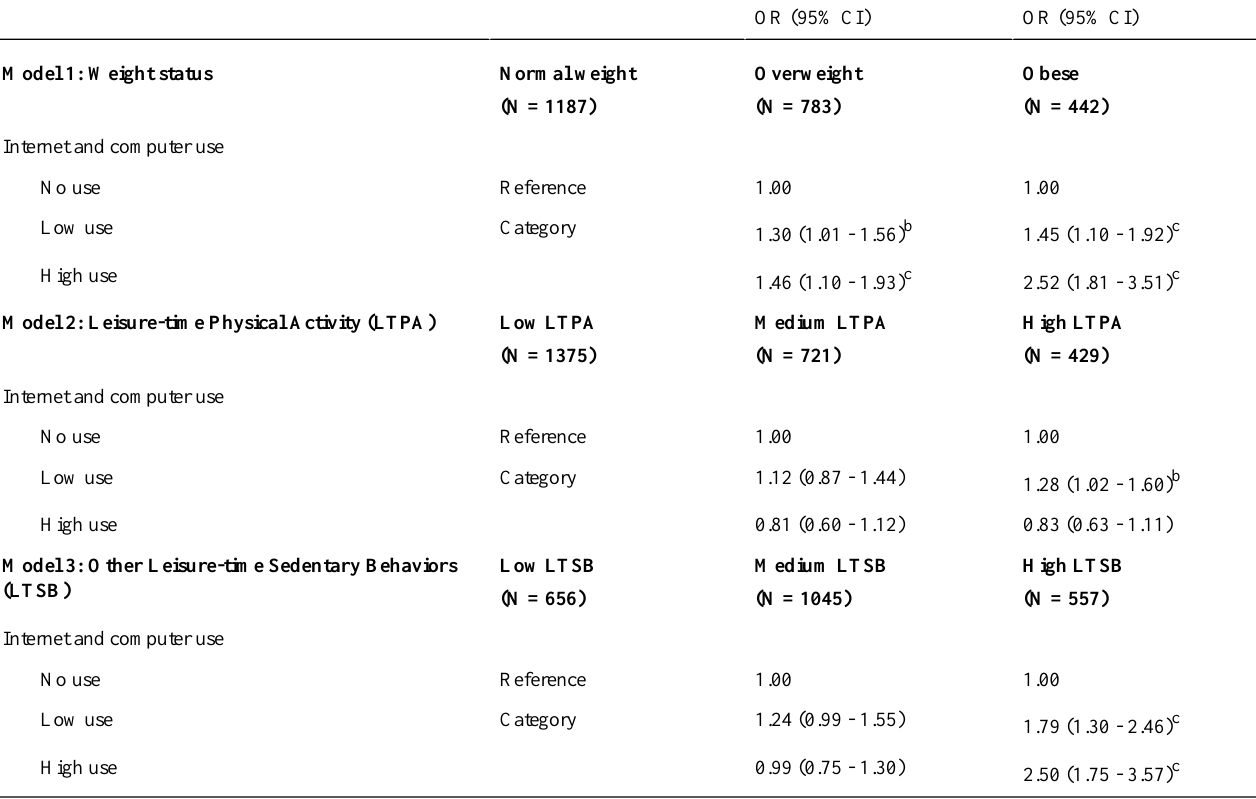
Table 2. Multinomial logistic regression models predicting overweight or obesity, leisure-time physical activity, and other sedentary behaviors by computer and Internet use